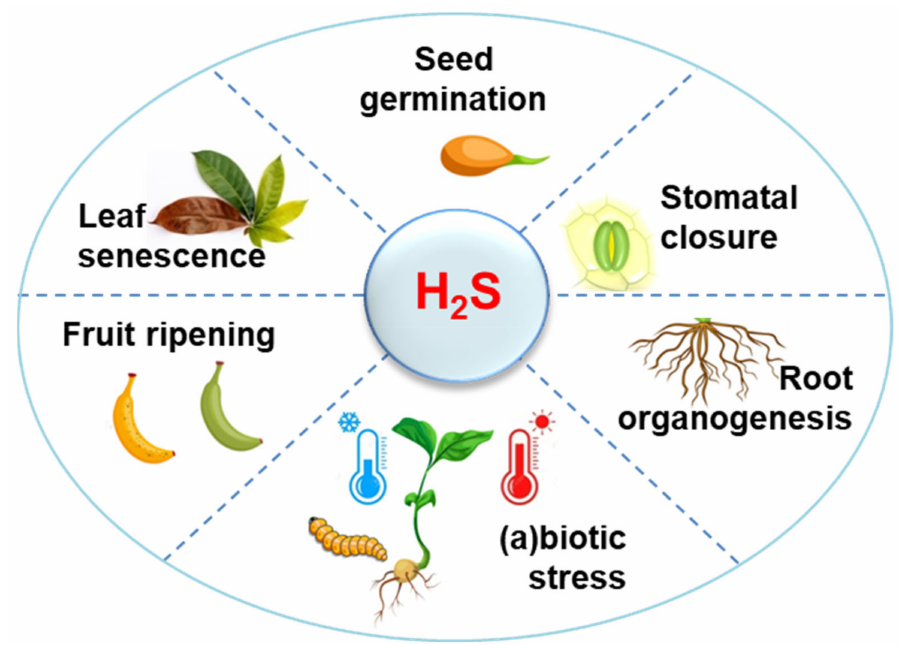
Figure 1. Main plant physiological and stressful processes where hydrogen sulfide (H 2 S) is involved. All these wide spectra of functions exerted by H 2 S are done usually in coordination with other molecules with regulatory properties such as nitric oxide, hydrogen peroxide, carbon monoxide, melatonin, abscisic acid, gibberellins, cytokinins, or